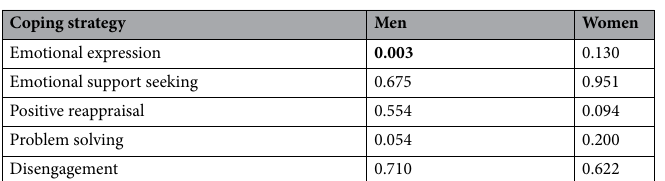
Table 4. P values for interactions between perceived stress and each coping strategy and eGFR by gender. P values were derived from the interaction terms included in Model 3 as described in Table 3. Bold font represents P <